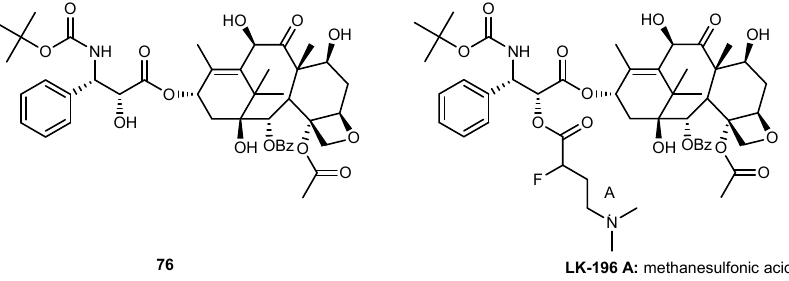
Figure 31. Chemical structure of docetaxel ( 76 ) and its novel prodrug LK-196.